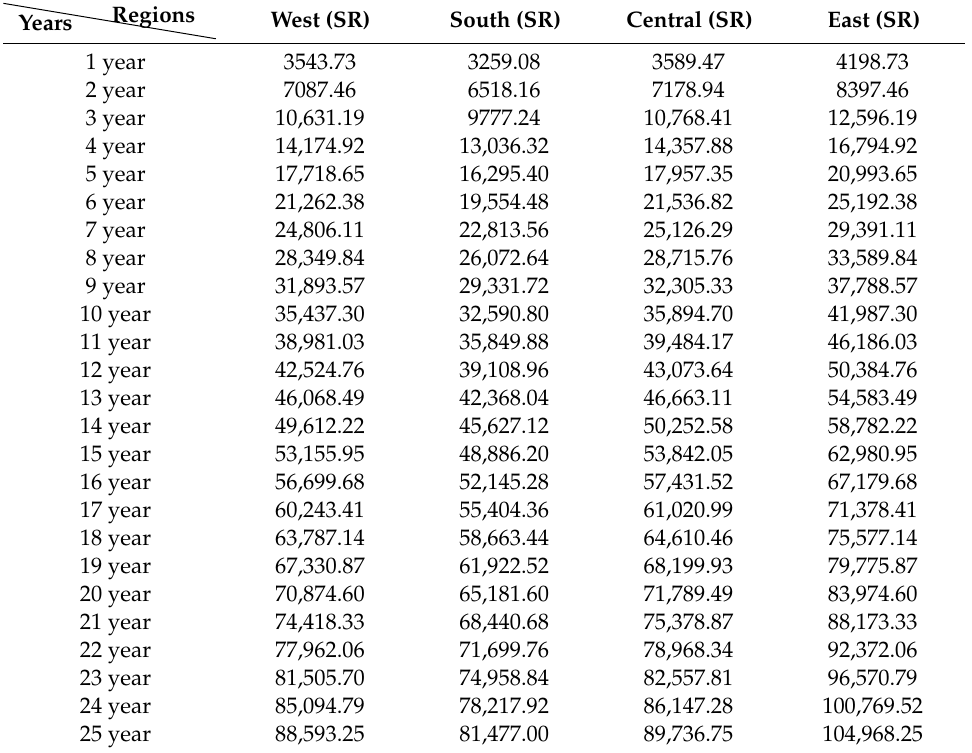
Table 13. The rate of return on investment due to energy generation in the KSA for di ff erent regions.